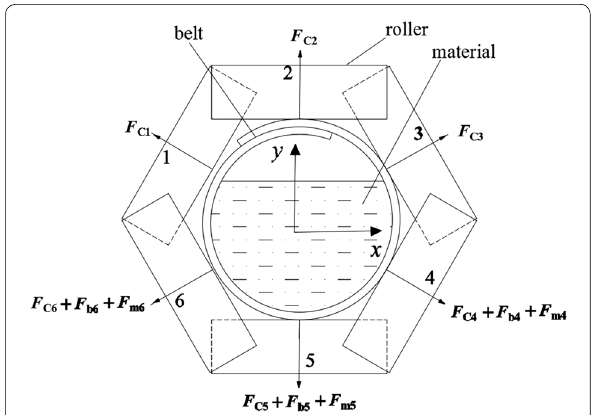
Figure 1 Force analysis of the